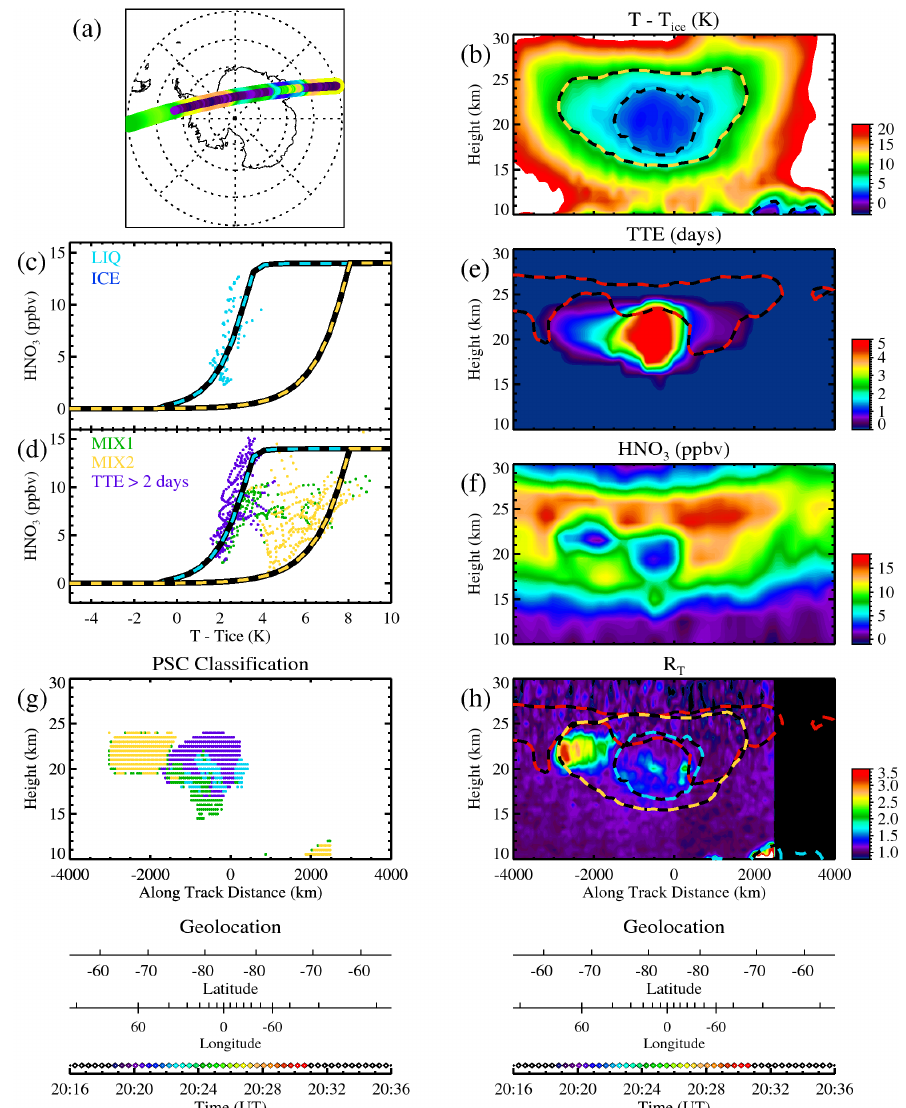
Fig. 14. As Fig. 7, but for orbit track 12 on 2 June 2008 (see Figs. 12f and 13f).